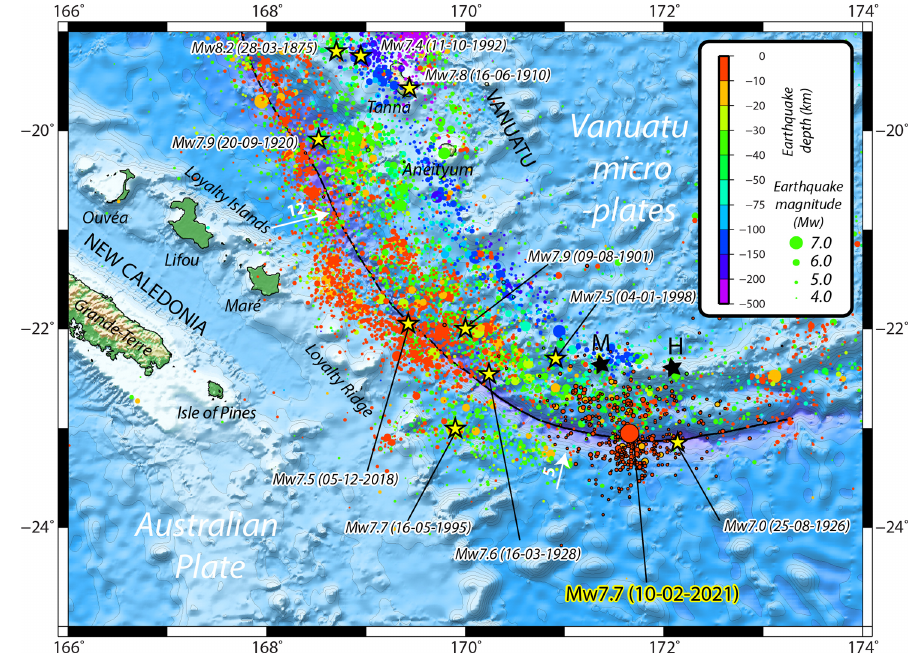
Figure 1. Local seismotectonic context: location of the 10 February 2021 M w 7.7 earthquake at the interface between the Australian plate and the Matthew–Hunter micro-plate (part of the Vanuatu micro-plates complex, southernmost Vanuatu arc). Earthquakes ( M w > 3.0) from USGS from 1 January 1970 to 31 March 2021 are shown by coloured circles, those with a black outline being recorded from the 10 February to 31 March. Convergence rates (in cmyr − 1 ) are represented by the white arrows. Yellow stars locate strong historical earthquakes ( M w ≥ 7.4) and the 25 August 1926 M w ≥ 7.0 easternmost earthquake. Note that not all tsunamigenic events are represented on this figure. The black line represents the subduction trench. The two black stars locate Matthew (M) and Hunter (H) islands. Topographic data is extracted from GEBCO2021 dataset (VLIZ/IOC,